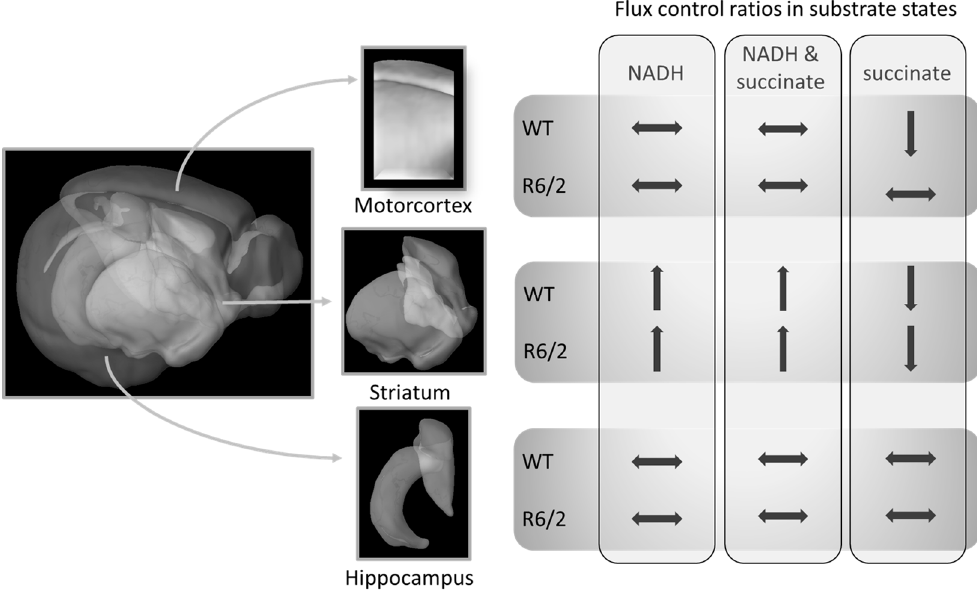
Figure 3. Relative mitochondrial respiration (flux control ratios) changes from 4- to 10–11-week-old mice differently in specific brain regions. These shifts in R6/2 were only altered in succinate-driven respiration as compared to wild-type (WT) mice. Brain Explorer 2 was used for the generation of brain region images.